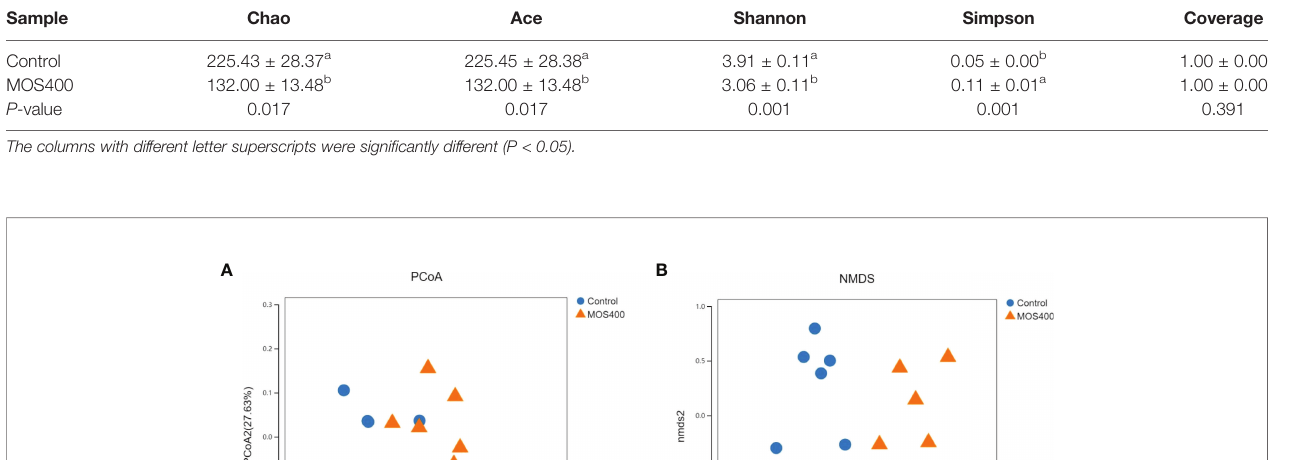
TABLE 4 | Richness and diversity statistics of M. amblycephala gut microbiota (mean ± SE). Sample